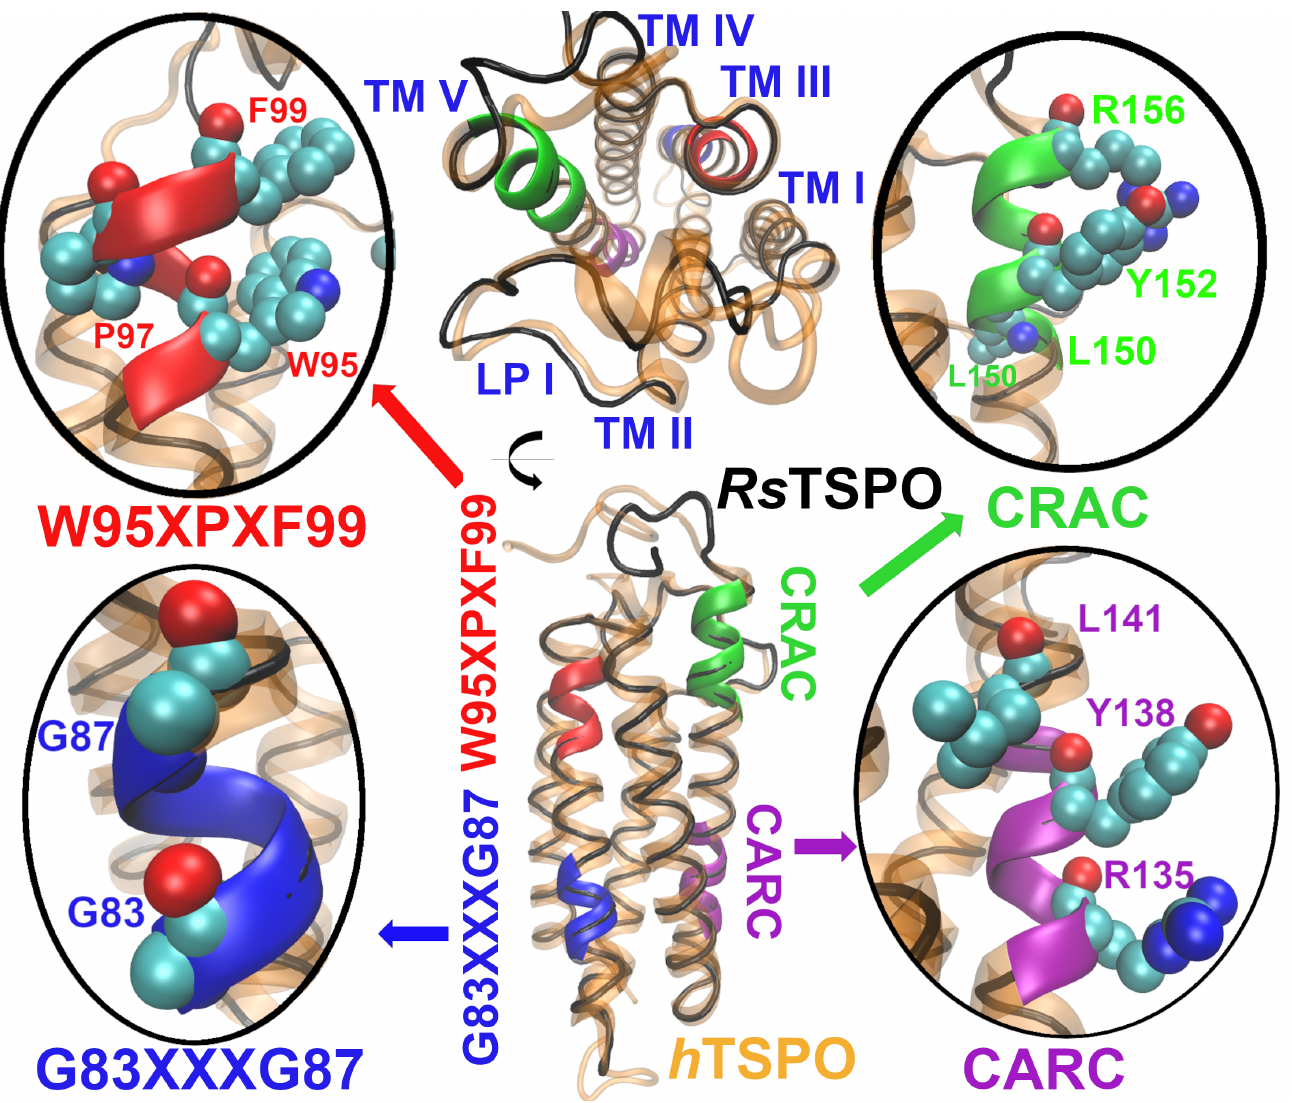
Figure 2. Top and side view of the structural model of the h TSPO monomer (orange cartoon representation) aligned with the Rs TSPO template (black tube representation). Four important functional regions are highlighted: cholesterol recognition/interaction amino acid consensus region (CRAC, in green color) and reverse region of the CRAC (CARC, in purple color), both involved in cholesterol binding, the G83XXXG87 motif (blue color) relevant for monomer–monomer interactions, and the W95XPXF99 motif (shown in red color) important for ligands binding. The figure was prepared with the VMD program